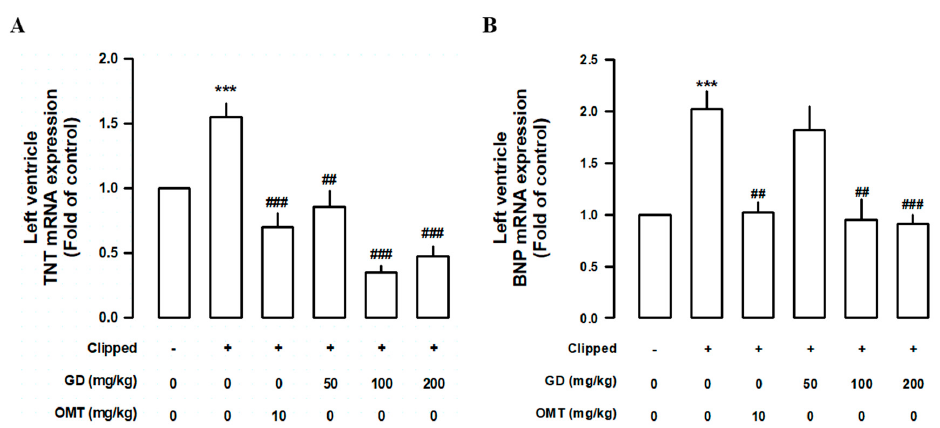
Figure 6. Effects of Gynura divaricata ( L .) DC (GD) on the biomarkers on cardiac dysfunction. ( A ) Effects of GD on the expression of troponin T (TnT) mRNA. Real time quantitative polymerase chain reaction of TnT mRNA was performed from the left ventricle; ( B ) E ff ects of GD on the expression of brain natriuretic peptide mRNA. Each value shows the mean ± standard error ( n = 10 per group). *** p < 0.001, vs. CONT and ## p < 0.01 ### p < 0.0001 vs.